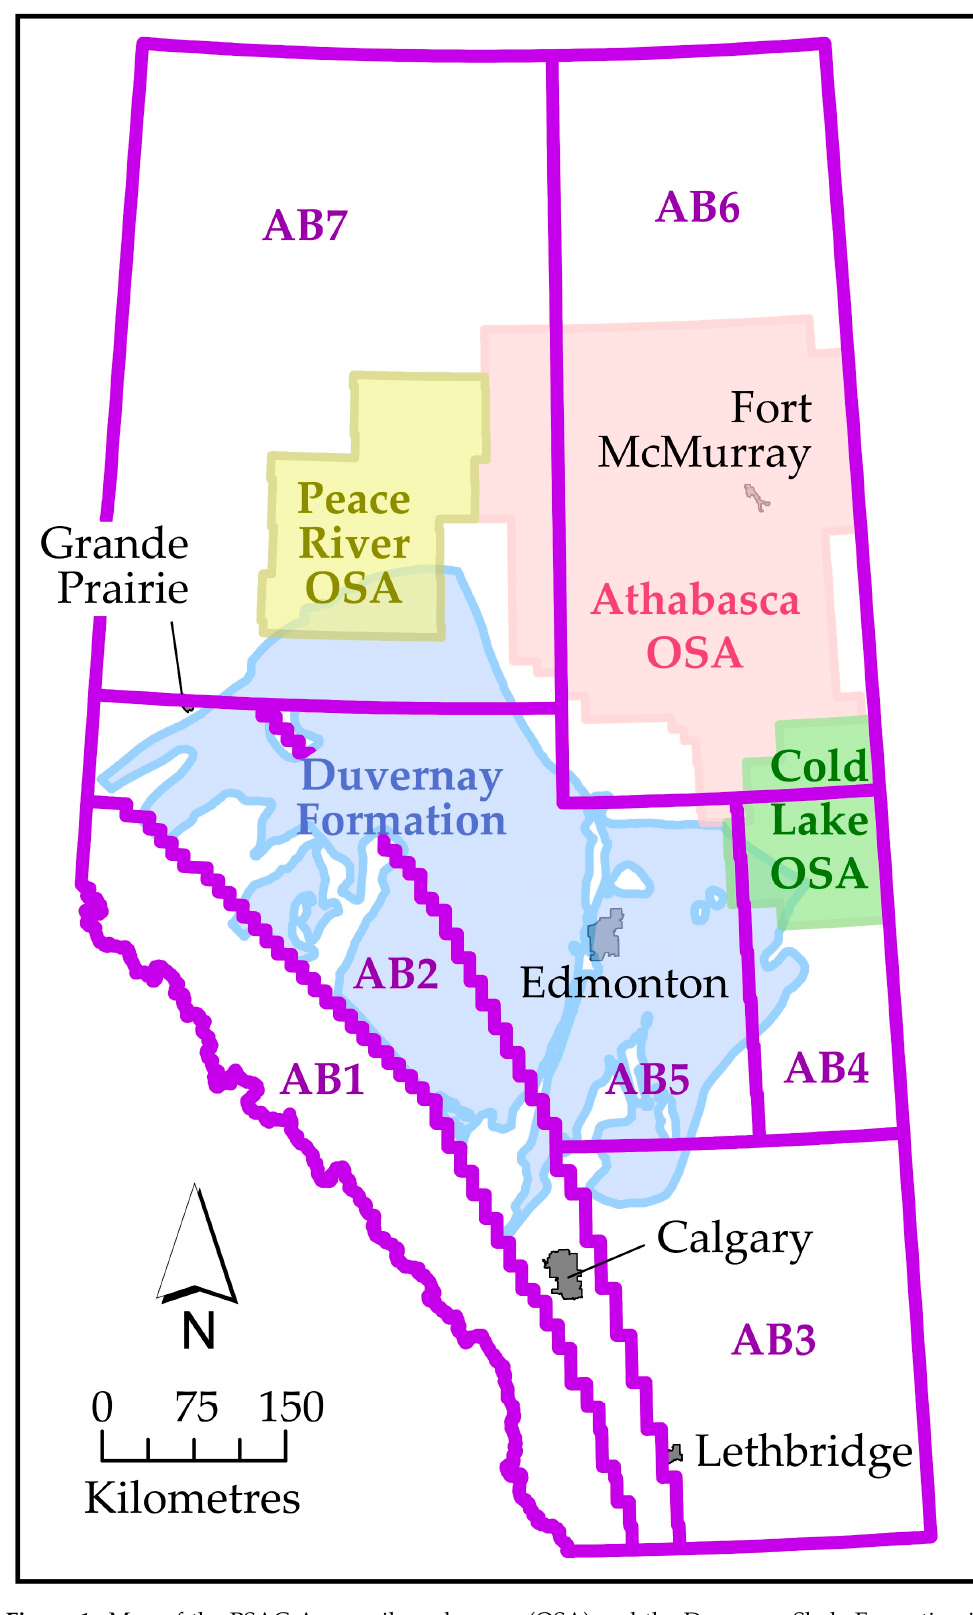
Figure 1. Map of the PSAC Areas, oil sands areas (OSA) and the Duvernay Shale Formation in Alberta. Courtesy of the Alberta Department of Energy.